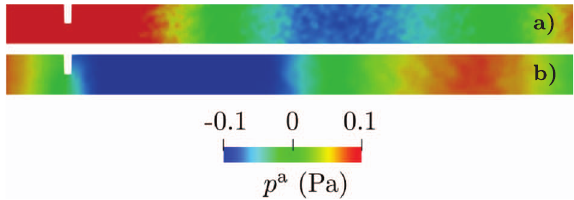
Figure 16. Instantaneous fi eld of the acoustic pressure of C1 obtained by (a) the PCWE-based propagation simulation and (b) by the RIB-based propagation simulation at t = 0.03 s.